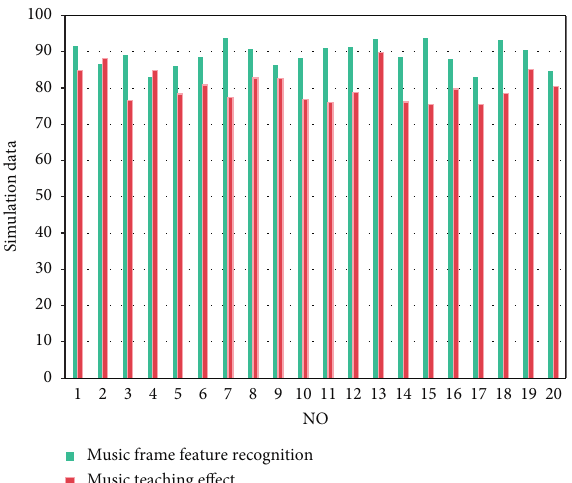
Figure 9: Music frame feature recognition effect comparison statistics.